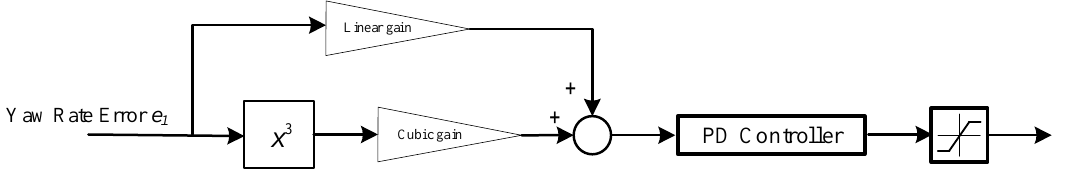
Figure 3. Error-cubic PD controller.